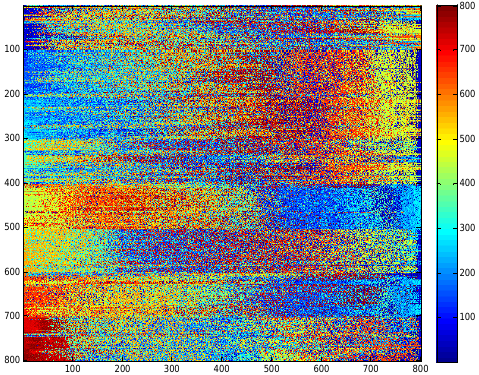
Figure 6. Retrieved image indexed by corresponding colour without employing pre-analysis stage.